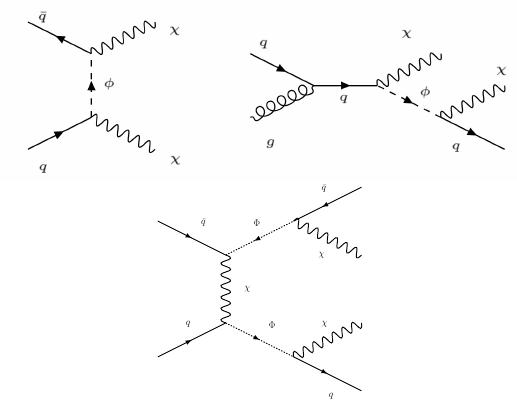
Figure 1: DM production via